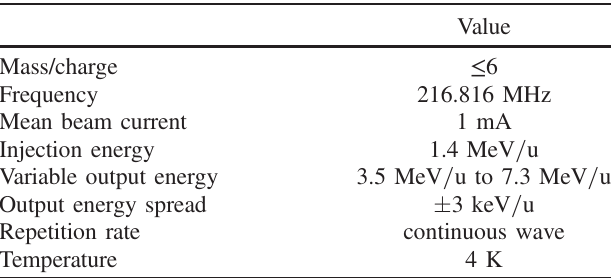
TABLE I. HELIAC design specifications [23].